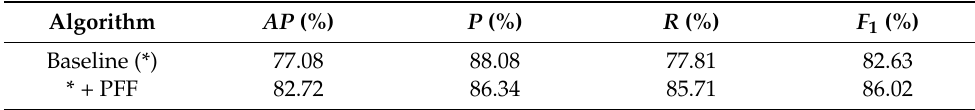
Table 2. Effectiveness of different components.